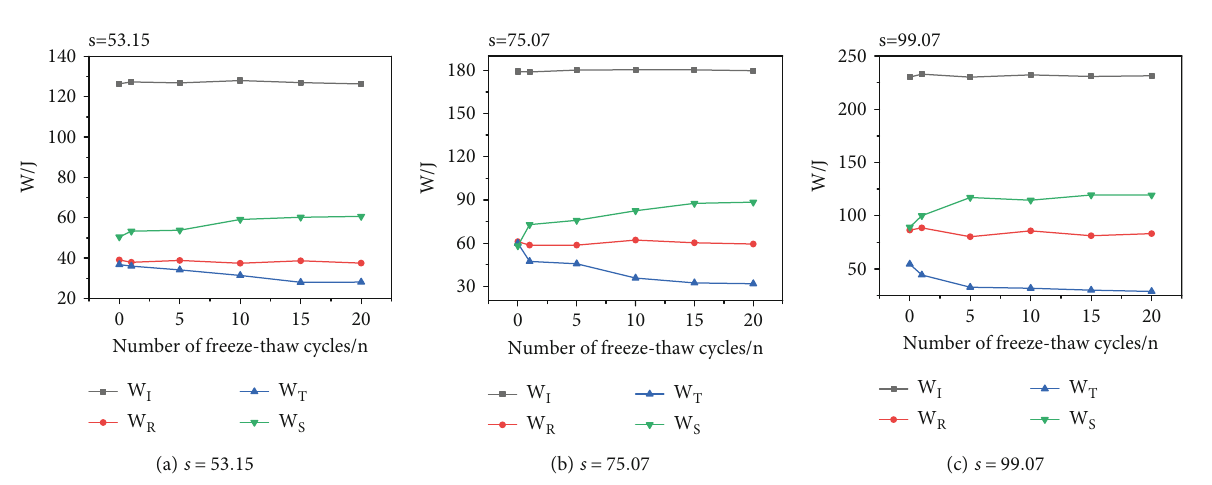
Figure 8: Four kinds of energy change curves under di ff erent strain rates and freeze-thaw